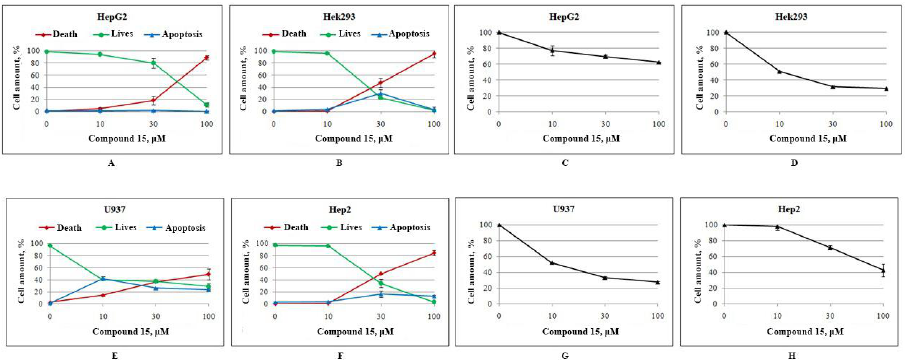
Figure 2. The influence of compound 15 on the viability of HepG2 ( A ), Hek293 ( B ), U937 ( E ), and Hep2 ( F ) after 48 h of incubation. Change in the number of cells HepG2 ( C ), Hek293 ( D ), U937 ( G ), and Hep2 ( H